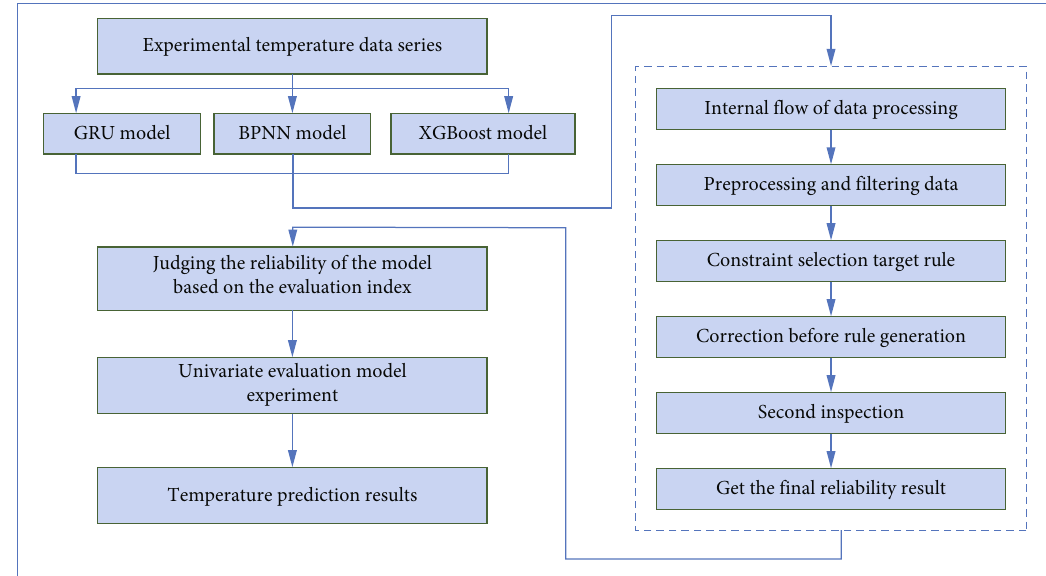
Figure 1: Flow chart of the prediction model.